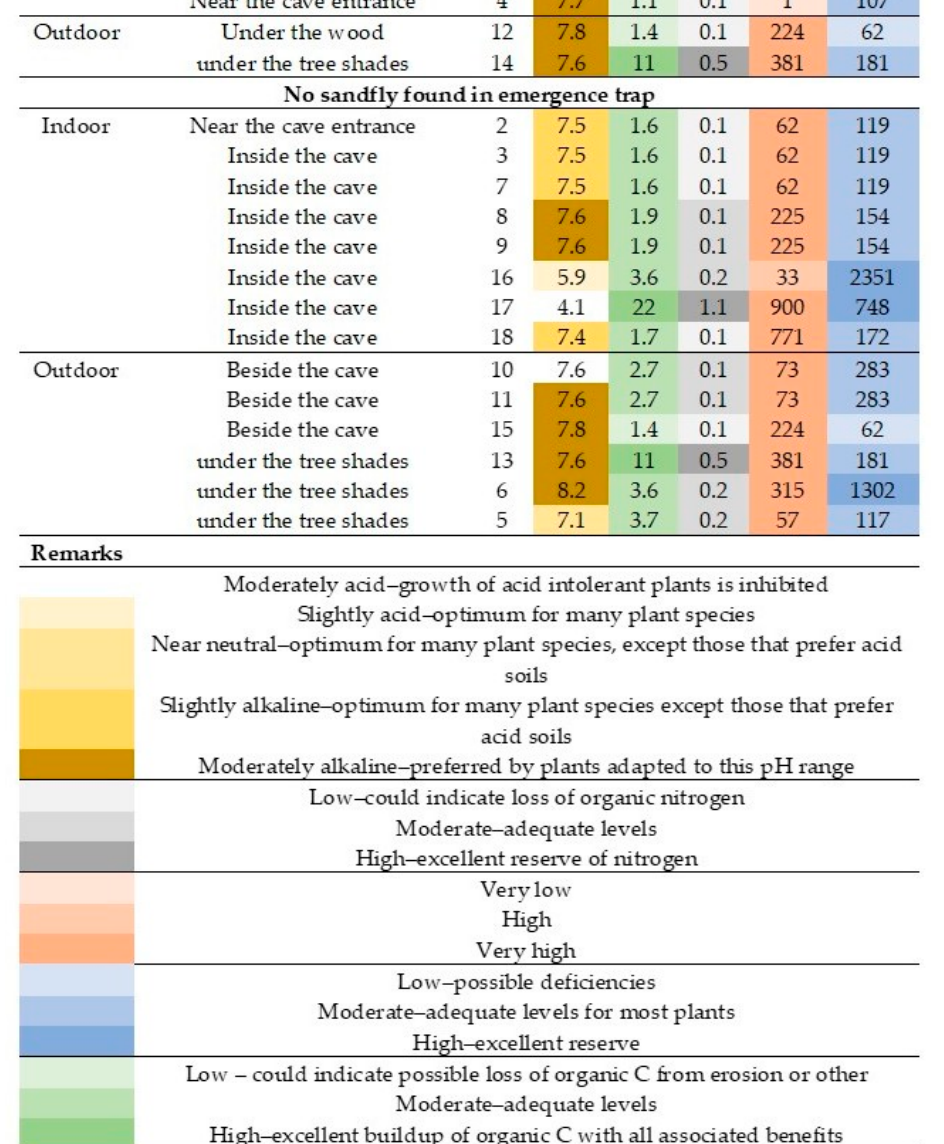
Figure 5. Soil parameters of potential sandfly breeding sites. Soil samples collected from emergence traps were assessed for levels of pH, organic matter (OM), nitrogen (N), phosphorus (P), and potassium (K).